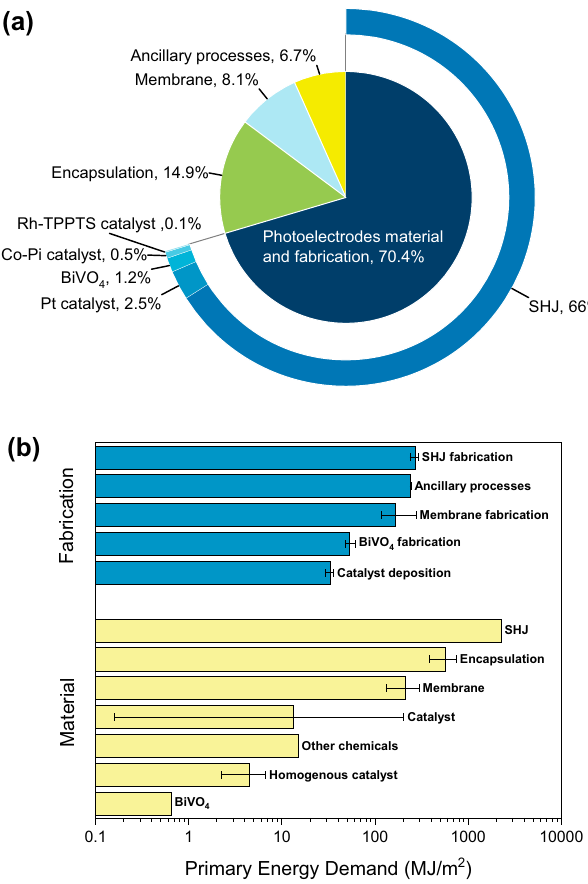
Fig. 2 | Cumulative energy demand of the coupled PEC device. a Energy dis- tribution pie-chart of our coupledPEC device indicating the contribution from the various components. Photoelectrodes material and fabrication consume the most energy (70.4%) and SHJ bottom absorber is the most energy-intensive component. b Logarithmic plot of the primary energy demand (MJ/m 2 ) of each component — divided into two categories: Material and Fabrication — of the coupled PEC device. Errors bars for cell fabrication and materials re fl ect the outcome from the uncertainty analysis.